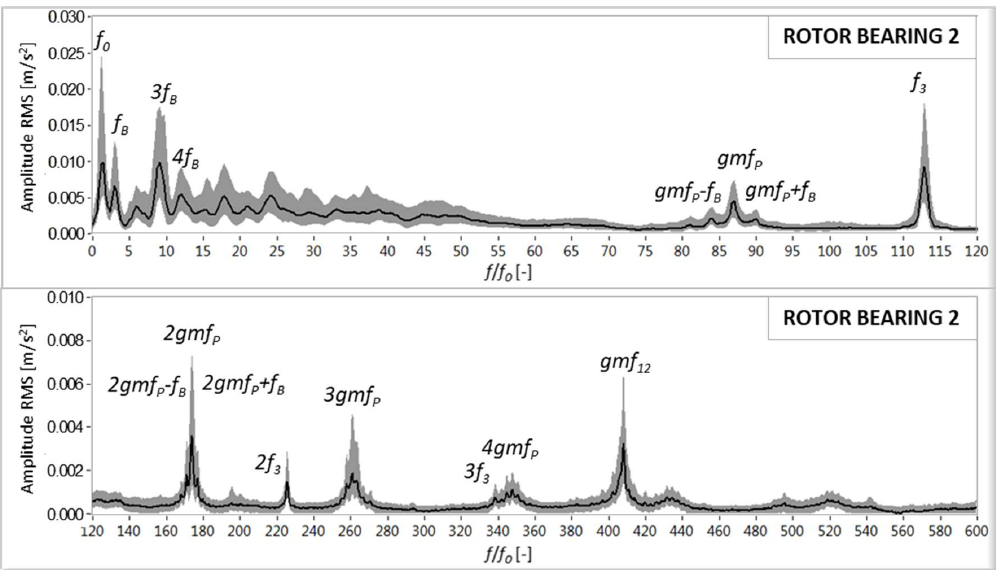
Figure 5. Median spectrum (black line) and amplitude levels between 25th and 75th percentiles (grey region) of the vibrations measured on the rear rotor bearing.